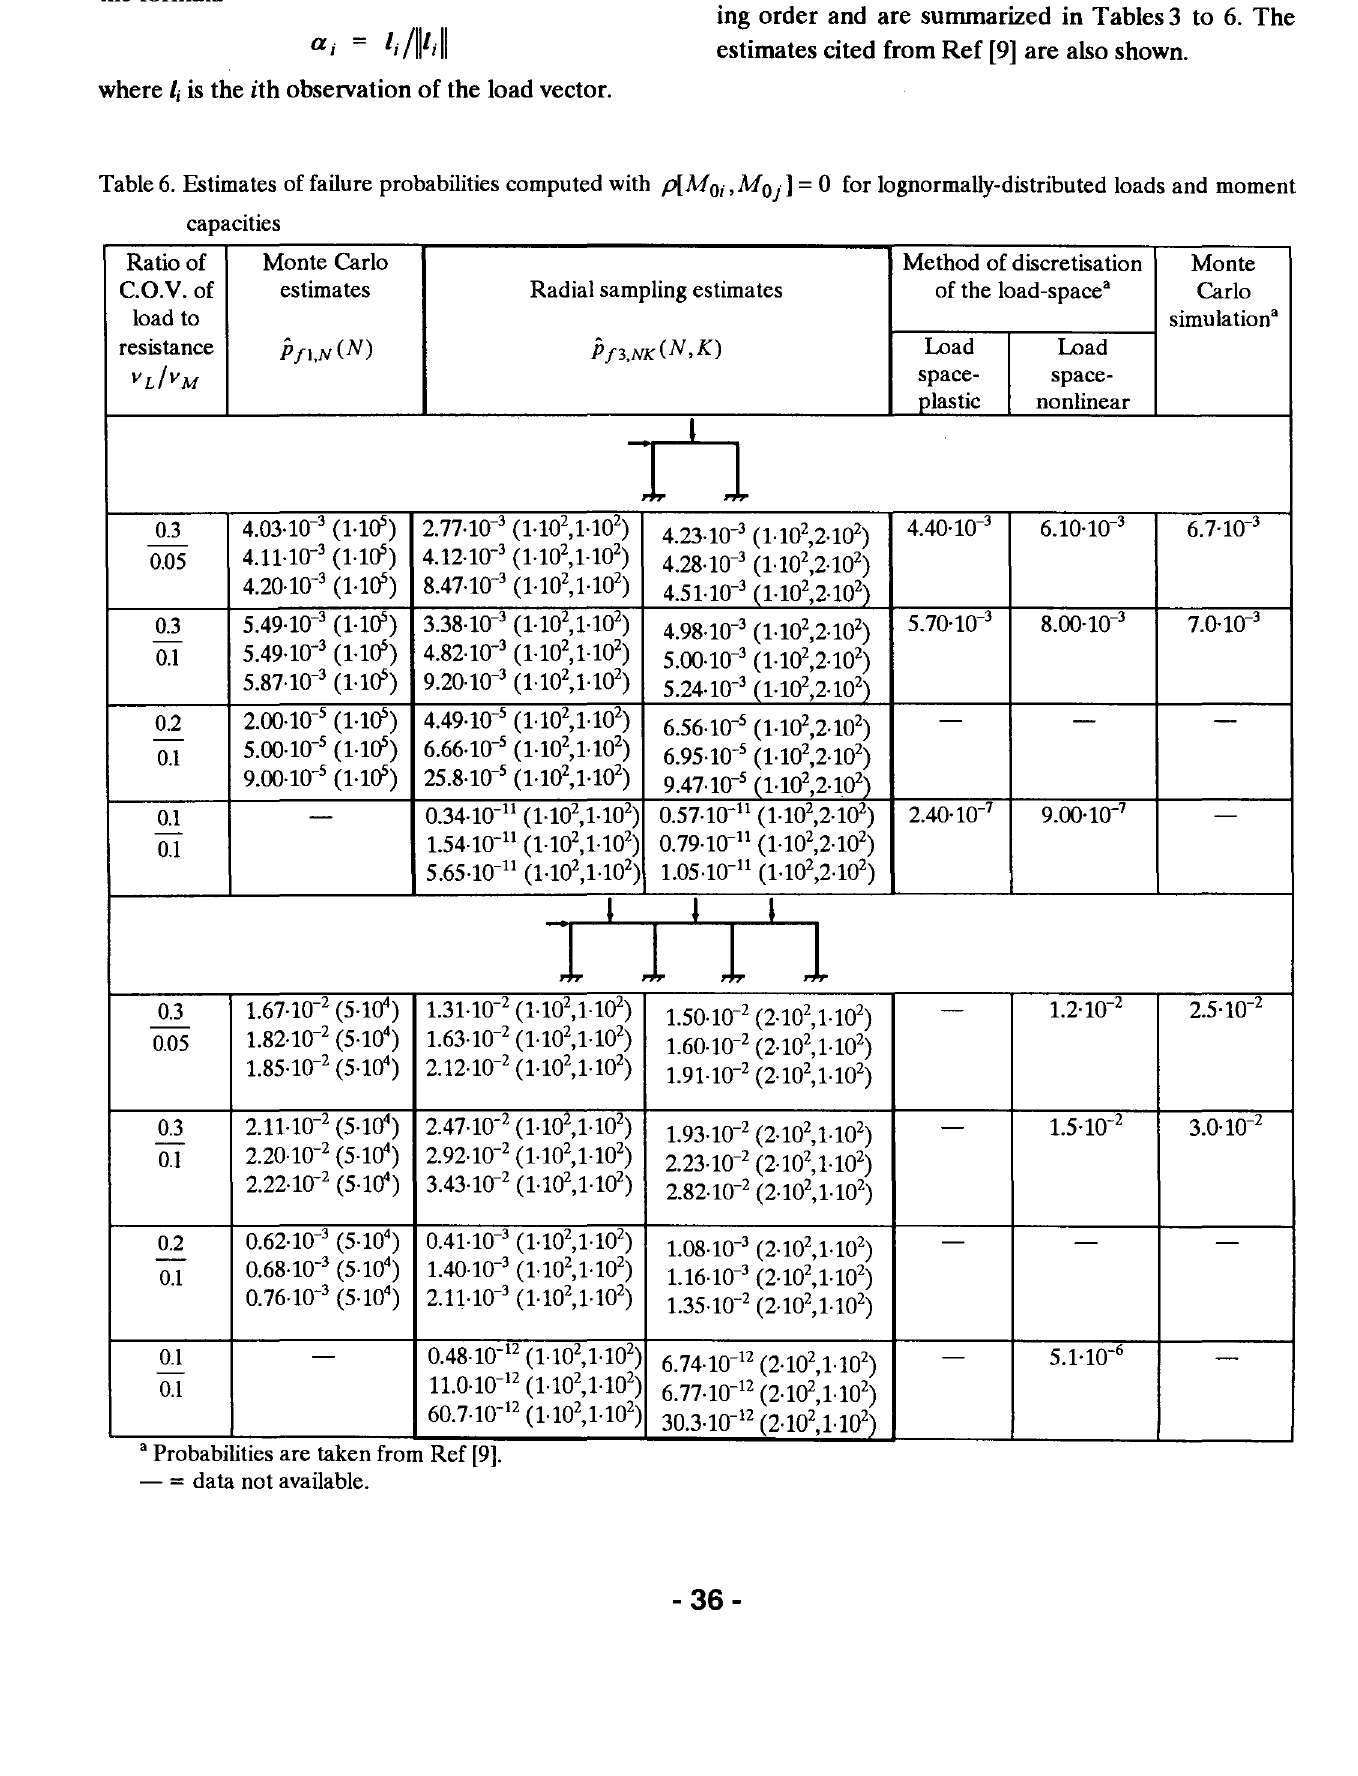
Table 6. Estimates of failure probabilities computed with p[ M o;, M 0 J] = 0 for lognormally-distributed loads and